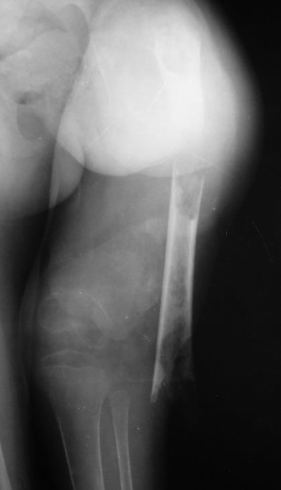
Figure 1. Radiograph of a 5-year-old child who presented with an extruded segment of the femoral diaphysis, skin loss and a flail limb. The short, osteopenic bone stumps do not allow reconstruction that requires good purchase of pins or wires, such as bone